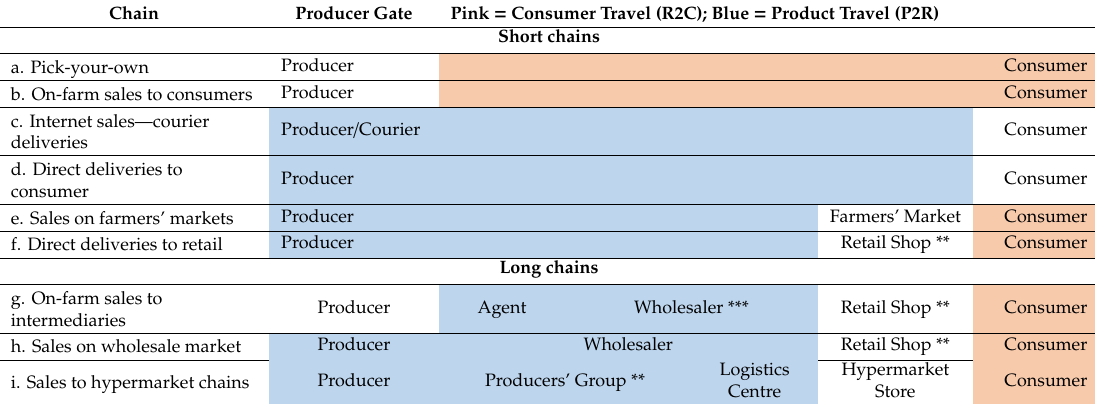
Table 3. Participation of producers, intermediaries and consumers in transportation activities in selected food supply